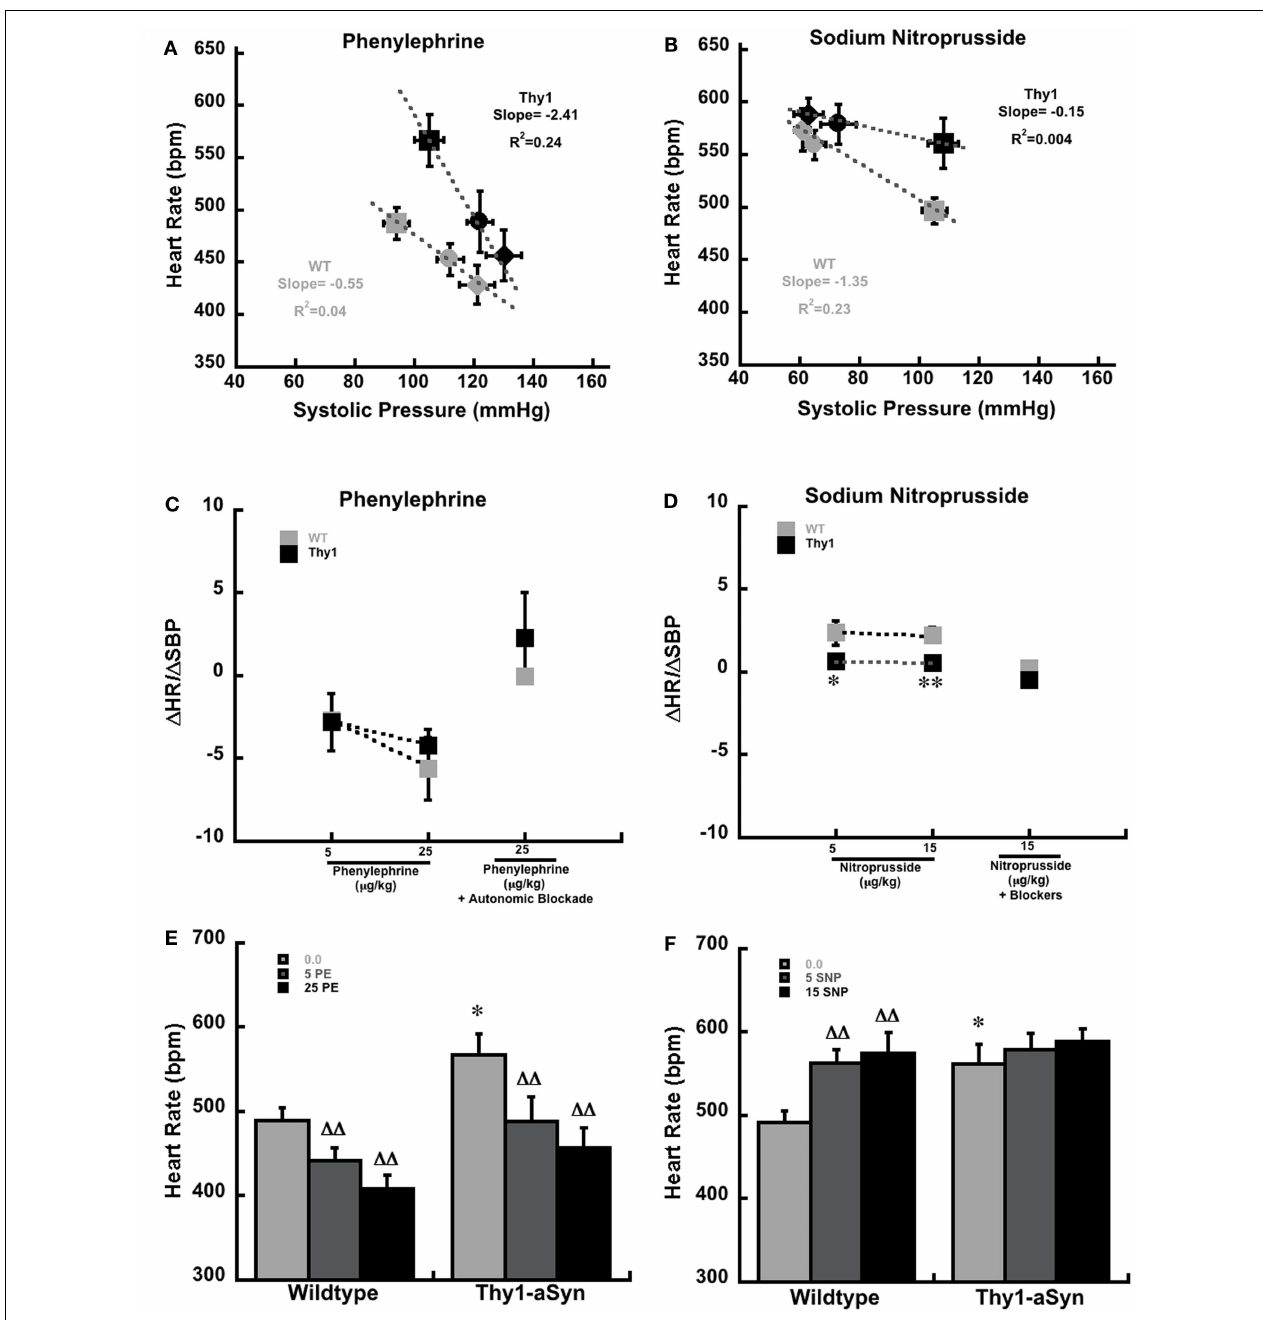
following autonomic blockade with glycopyrrolate and propanolol (C) . ∆ HR/ ∆ SBP following serial doses of sodium nitroprusside alone and sodium nitroprusside (15 µ g/kg) following autonomic blockade with glycopyrrolate and propanolol (D) . *, **Represents p < 0.05, 0.01, respectively compared toWT at the same dose. Heart rate measurements at baseline (0.0 µ g/kg) and following serial doses of phenylephrine [5 and 25 µ g/kg; (E) ]. Heart rate measurements at baseline (0.0 µ g/kg) and following serial doses of sodium nitroprusside [5 and 15 µ g/kg; (F) ]. *Represents p < 0.01 compared toWT at same dose, DD represents p < 0.01 compared to baseline (0.0) within same genotype (Student’s t -test and mixed design ANOVA followed by Fisher’s